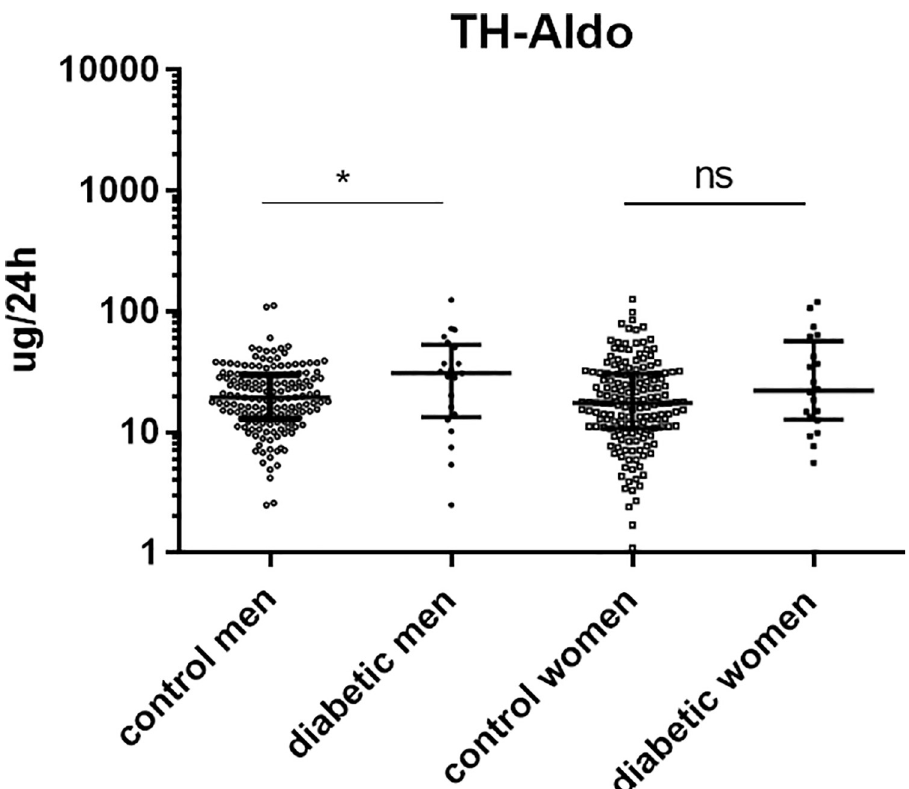
Fig 1. Urinary excretion of tetrahydroaldosterone (TH-Aldo) in diabetic patients and healthy controls. Urinary excretion of the mineralocorticoid metabolite TH-Aldo in healthy controls (n = 155 men, n = 161 women) and diabetic patients (n = 21 men, n = 20 women) measured by GC-MS. The groups were matched for age and gender. Diabetic men significantly excreted more TH-Aldo then their controls, while this finding was not significant in women. TH-Aldo � p = 0.031 (men), ns = not significant (women). Kolmogorov-Smirnov test (non-parametric, unpaired). Dot blot is shown with Log (10) scale and steroid concentrations are displayed in ug/24h. White circles = control men, black circles = diabetic men, white squares = control women, black squares = diabetic women. � p < 0.05, �� p < 0.01, ��� p < 0.0001, ns = not significant.